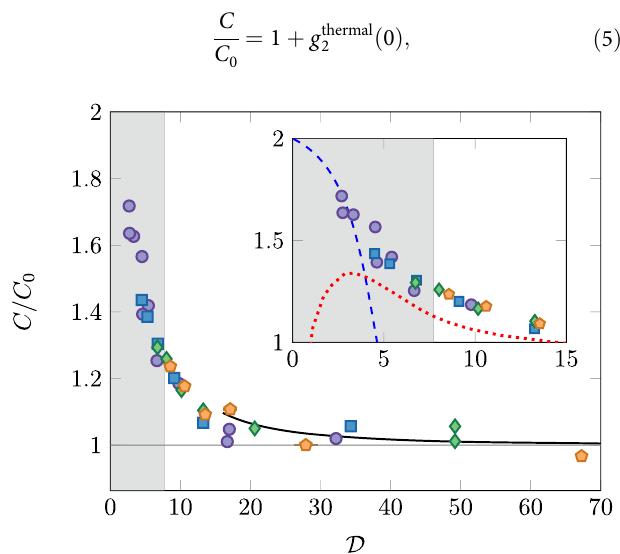
Fig. 3 Contact measurement. Variations of the normalized Tan ’ s contact C / C D . The encoding of the experimental 0 with the phase-space density points is the same as in Fig. 2. The colored zone indicates the non- (cid:2) 7 : 7. The continuous black line super fl uid region, corresponding to D < D c shows the prediction derived within the Bogoliubov approximation. Inset: Zoom on the critical region. The dashed blue line is the prediction from ref. 46 , resulting from a virial expansion for the 2D Bose gas. The dotted red line shows the results of the classical fi eld simulation of ref. 47